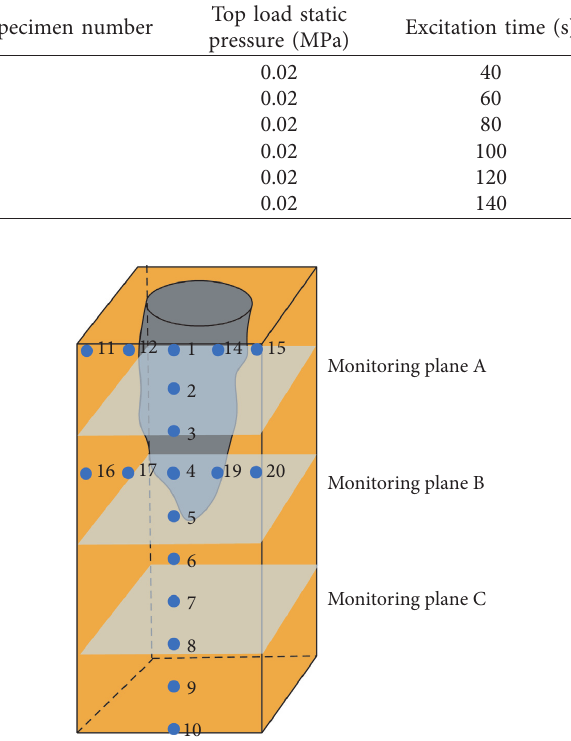
Figure 5: Measurement points distribution for the rectangular